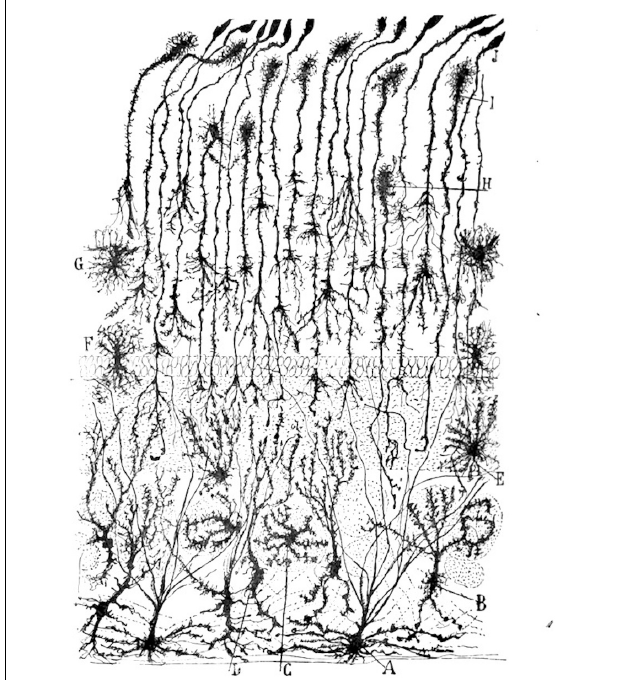
FIGURE 4 | Cajal’s illustration of glial cells in the olfactory bulb of a kitten. The image resembles the forested landscapes shown in Figures 1 , 2 . Digital reproduction of Figure 743 in Santiago Ramón y Cajal, Textura del sistema nervioso del hombre y los vertebrados, Volume 2, Pt. 2 (Imprenta y librería de Nicolás Moya, Madrid, 1904), 936. Available at http://www.google.com/